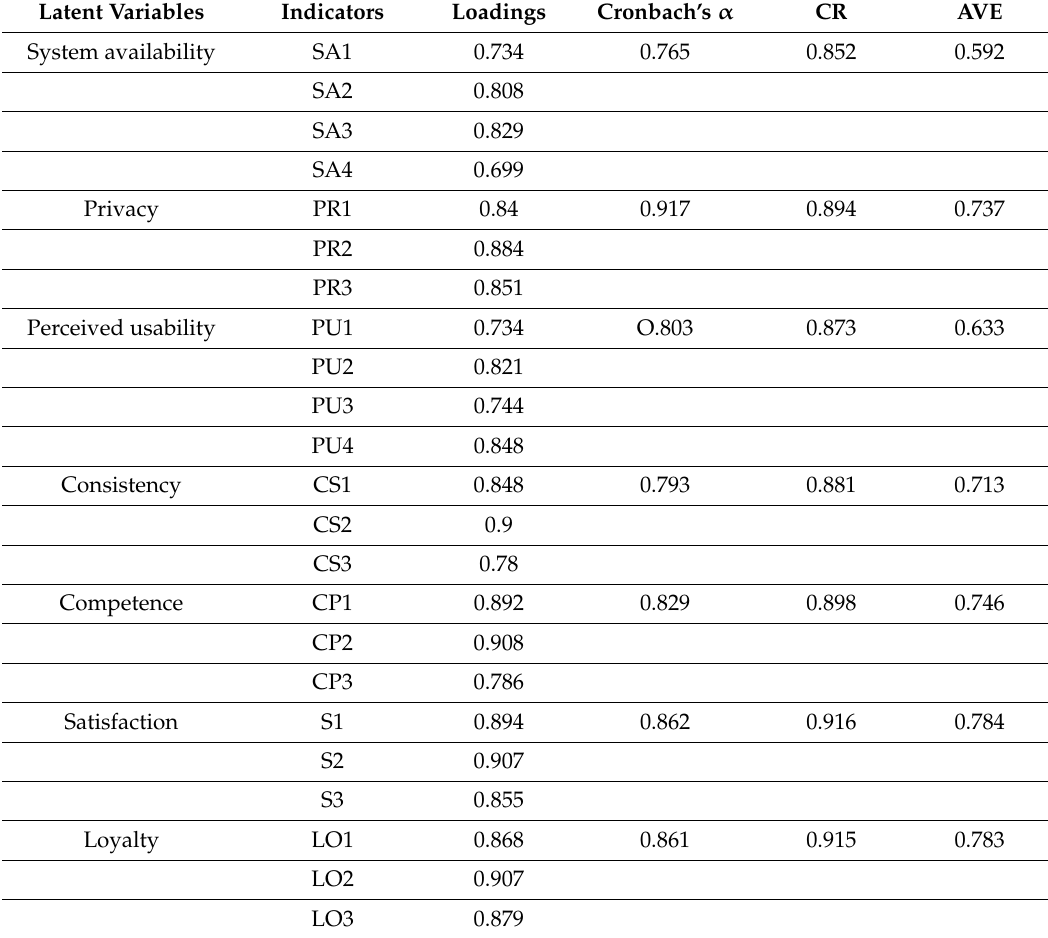
Table 4. Test for reliability and convergent validity.